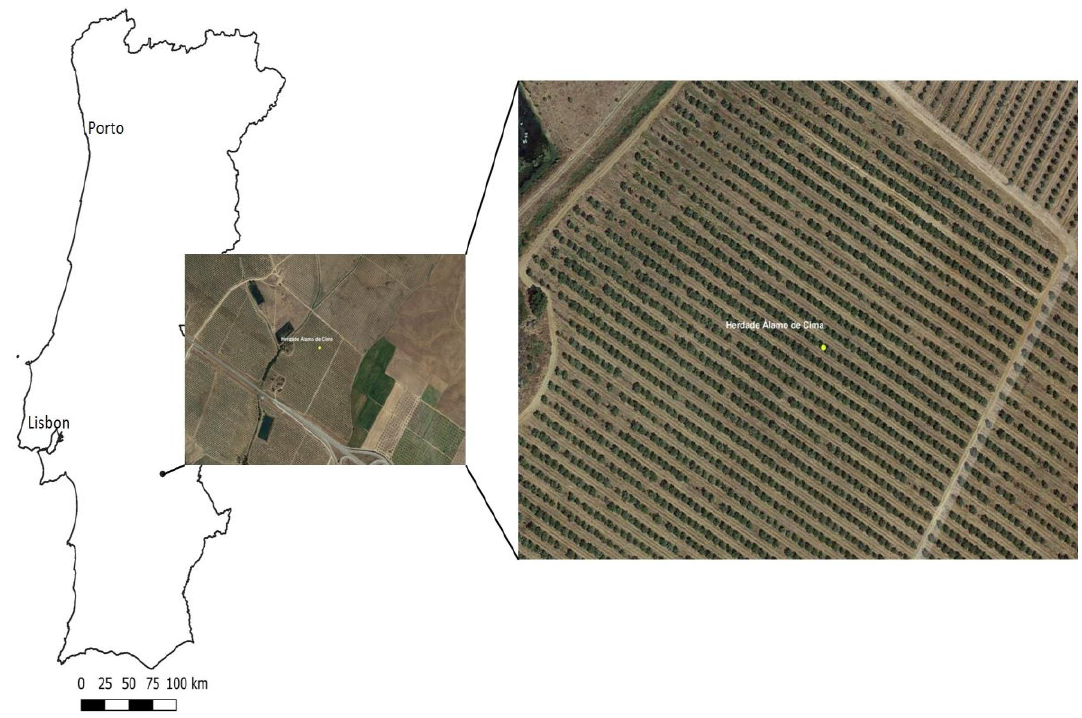
Figure 1. Location of the study area in southern Portugal ( a ) with identification of the intensive commercial olive orchard at the Herdade Á lamo de Cima near Évora (38°29′49.44″ N, 7°45′8.83″ W altitude 75 m), in the Alentejo region ( b ).